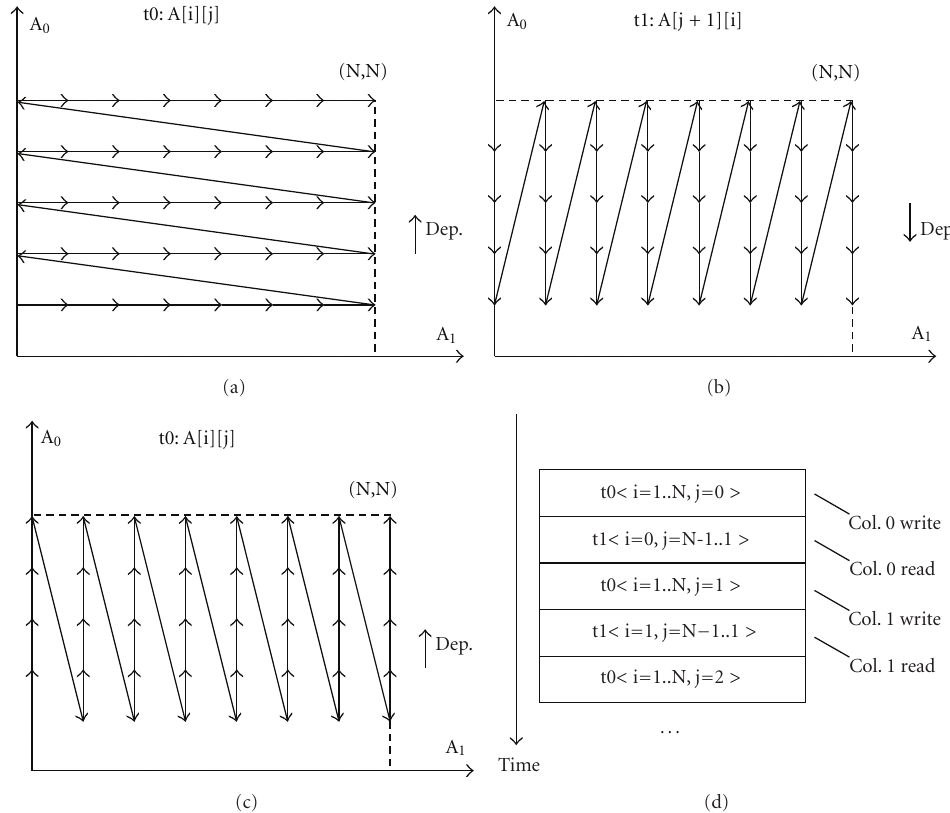
Figure 7: (a) Initial access order of t0 writes. (b) Initial access order of t1 reads. (c) Optimized access order of t0 writes. (d) Optimized task instance scheduling for bu ff er reduction.